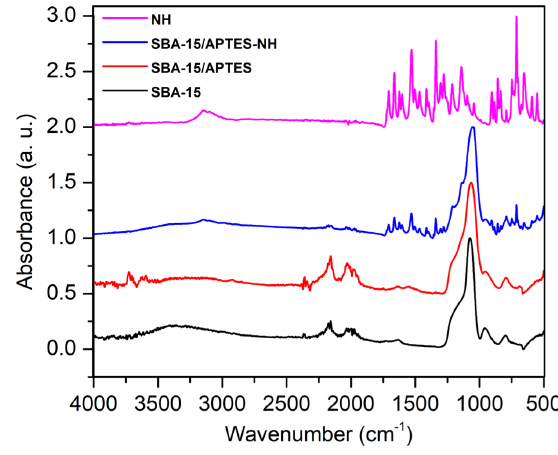
Figure 1: FT-IR spectrum of SBA-15 (black line), SB-15/APTES (red line), SBA-15/APTES-NH (blue line) and ligand NH (pink